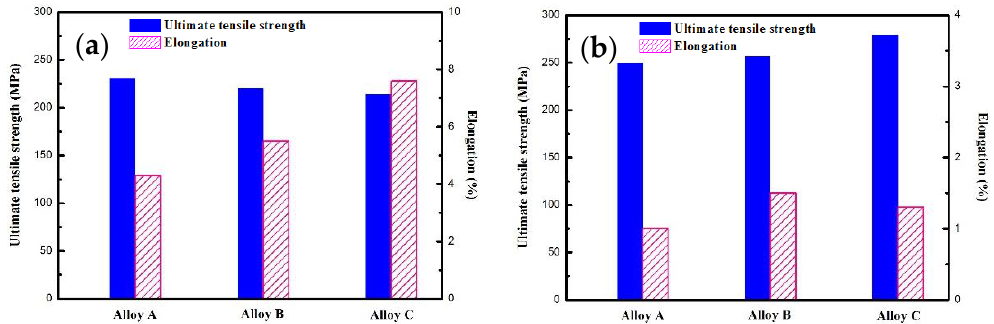
Figure 7. Room temperature tensile results of the alloys with different tempers: ( a ) Solution treated condition, ( b ) T6.